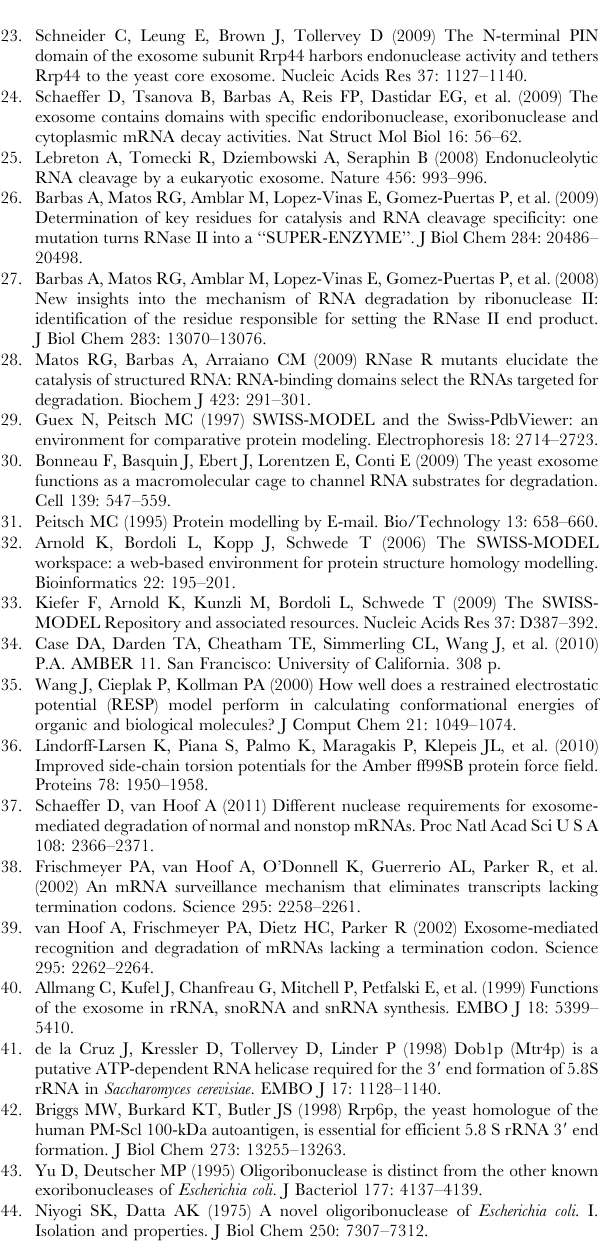
Table S1 Average RMSD values. Average RMSD values obtained from the last nanosecond of free molecular dynamics trajectories of the three yeast Rrp44-ssRNA interaction models calculated. Data correspond to peptide-backbone trace of RNB domains and nucleotides RA1–RA5 in RNA bound molecules